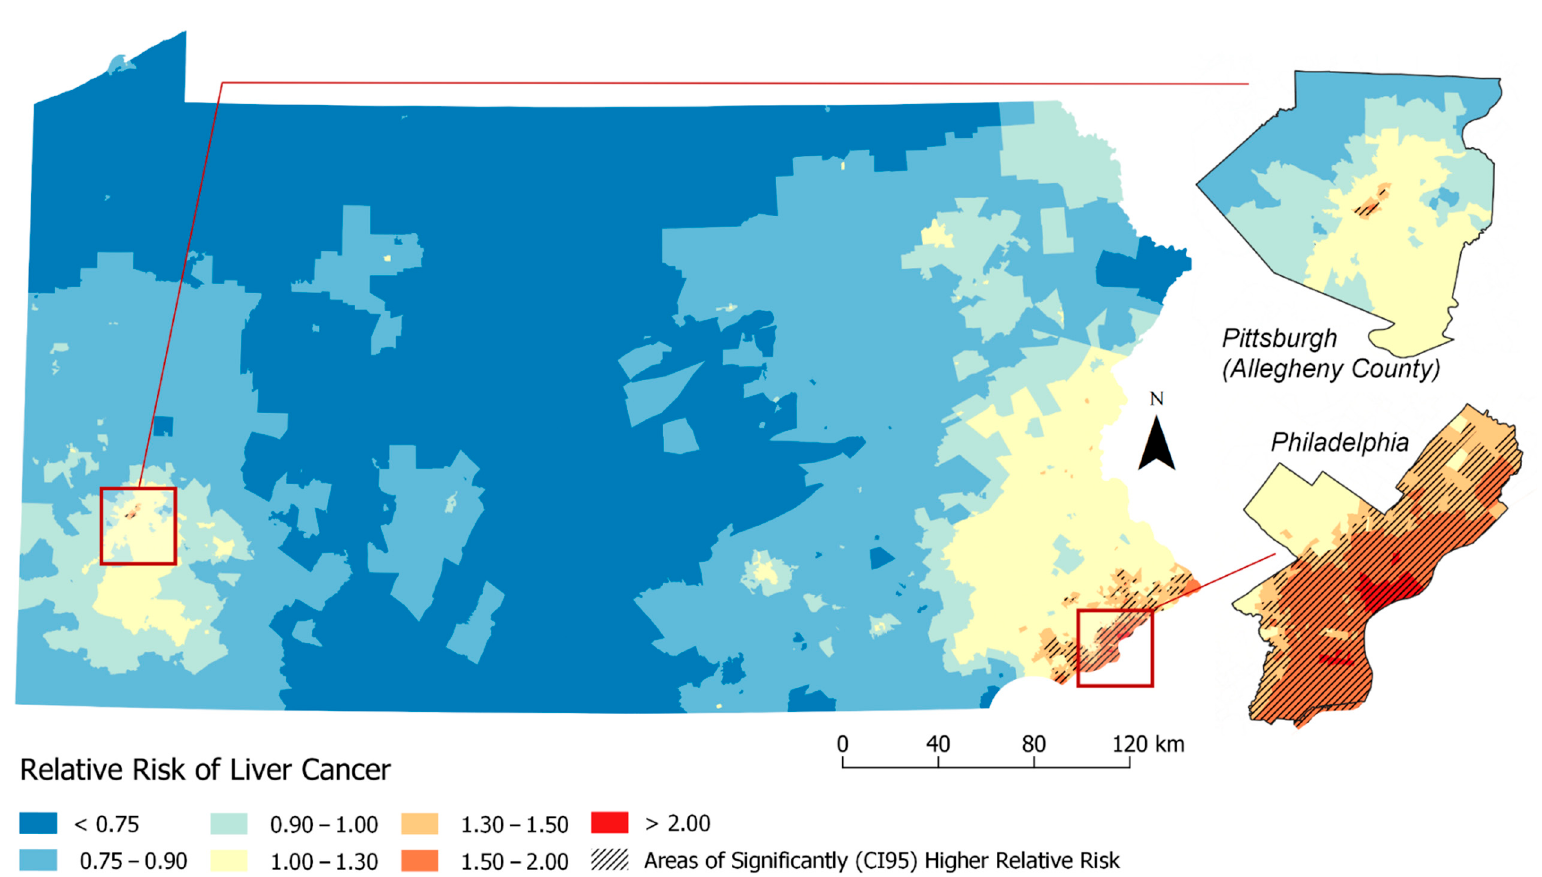
Figure 4. Relative Risk Estimates for Liver Cancer by Census Tract (Model 11. Adjusted for: individual-level factors + previous neighborhood variables (% Non-Hispanic Black (% NHB), Hispanic ICE and Neighborhood Instability) + ICE-Income/Yost)